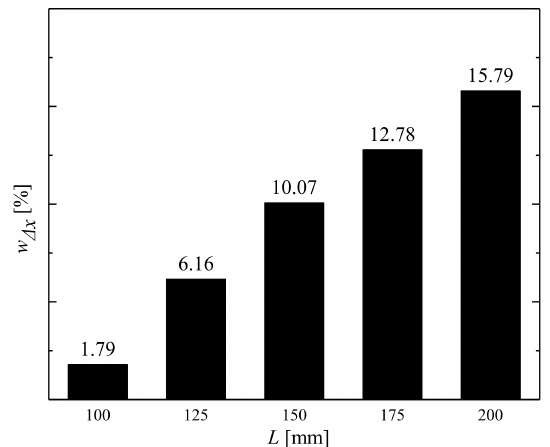
Figure 17. Variation in w ∆ x with different axial lengths.